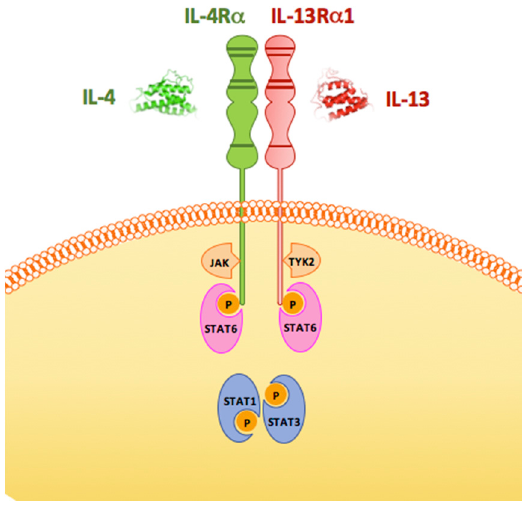
Figure 1. Schematic representation of the heterodimeric receptor for IL-13 and IL-4 and its signaling. Interleukins 13 (IL-13) and 4 (IL-4) can bind to the same heterodimeric receptor composed of the IL-13 Receptor alpha 1 (IL-13R α 1) and the Interleukin 4 Receptor alpha (IL-4R α ). Binding of the receptor activates the Janus kinase (JAK) and leads to phosphorylation of members of the Signal Transducer and Activator of Transcription (STAT) family. The tyrosine-protein kinase 2 (TYK2) is a member of the JAK family. See the text for more details.